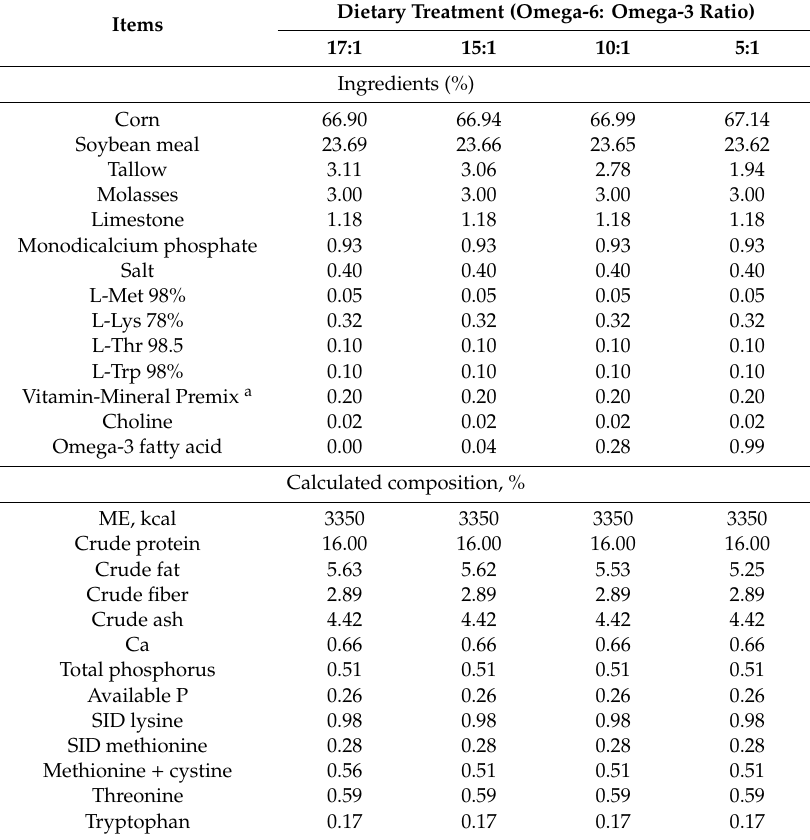
Table 1. Composition of basal diets (as-fed basis)